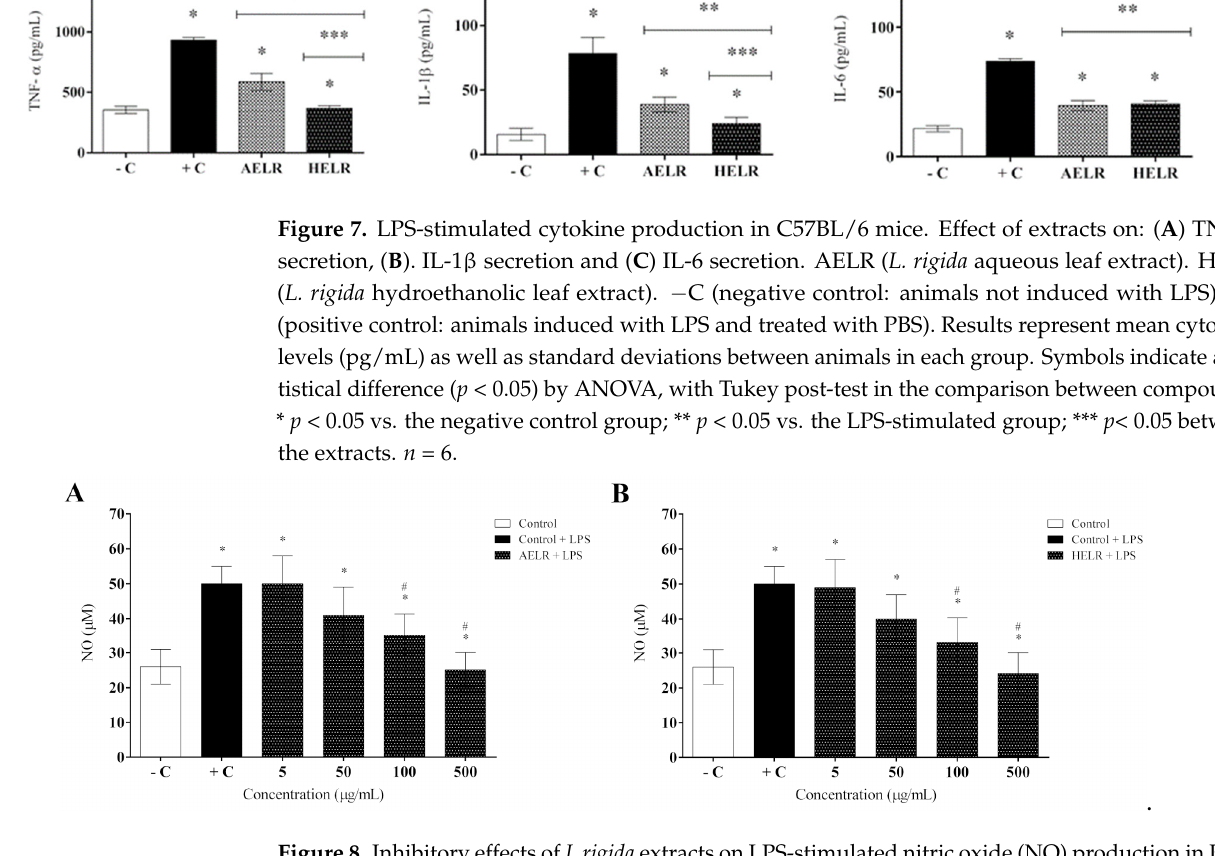
Figure 7. LPS-stimulated cytokine production in C57BL/6 mice. Effect of extracts on: ( A ) TNF- α secretion, ( B ). IL-1 β secretion and ( C ) IL-6 secretion. AELR ( L. rigida aqueous leaf extract). HELR ( L. rigida hydroethanolic leaf extract). − C (negative control: animals not induced with LPS). +C (positive control: animals induced with LPS and treated with PBS). Results represent mean cytokine levels (pg/mL) as well as standard deviations between animals in each group. Symbols indicate a statistical difference ( p < 0.05) by ANOVA, with Tukey post-test in the comparison between compounds. * p < 0.05 vs. the negative control group; ** p < 0.05 vs. the LPS-stimulated group; *** p < 0.05 between the extracts. n = 6.